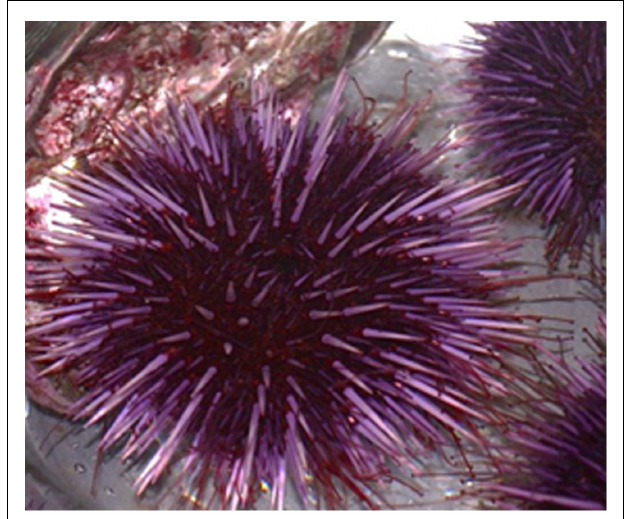
FIGURE 1 |An adult California purple sea urchin, Strongylocentrotus purpuratus . Image kindly provided by Hung-Yen Chou andYen-Lin Kuo.